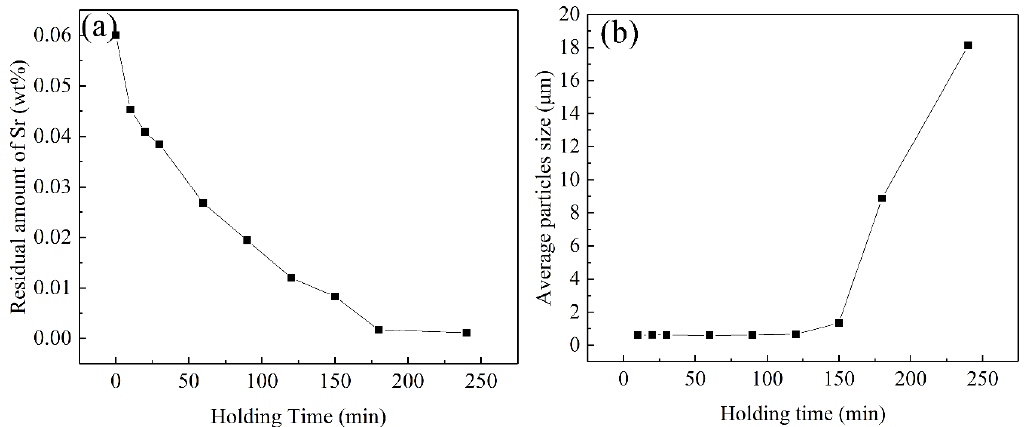
Figure 4. Morphology of the eutectic Si cast from the melt with 0.06 wt.%Sr addition holding for different times at 750 °C: ( a ) 10 min, ( b ) 20 min, ( c ) 30 min ( d ), 60 min, ( e ) 90 min, ( f ) 120 min, ( g ) 150 min, ( h ) 180 min, and ( i ) 240 min.